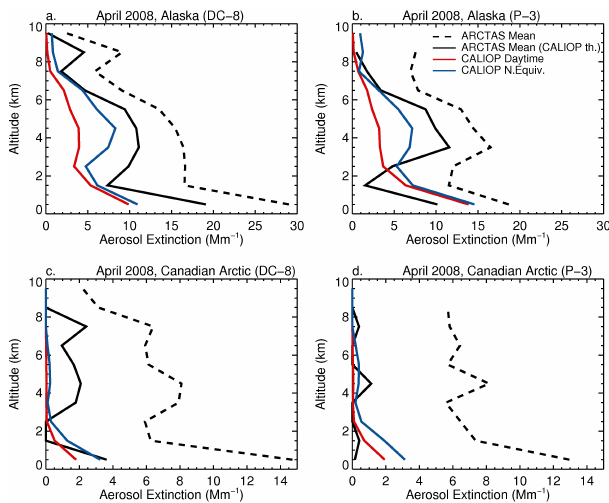
Fig. 7. Comparison between CALIOP and ARCTAS mean extinc- tion profiles for the DC-8 and P-3 flight days over AK (a, b) and CAR (c, d) in April 2008. In situ aircraft profiles of extinctions are shown with (solid black line) and without (dashed black line) the CALIOP nighttime threshold applied. The red line shows the CALIOP standard (daytime) mean extinction profile, whereas a blue line indicates the nighttime-equivalent mean extinction